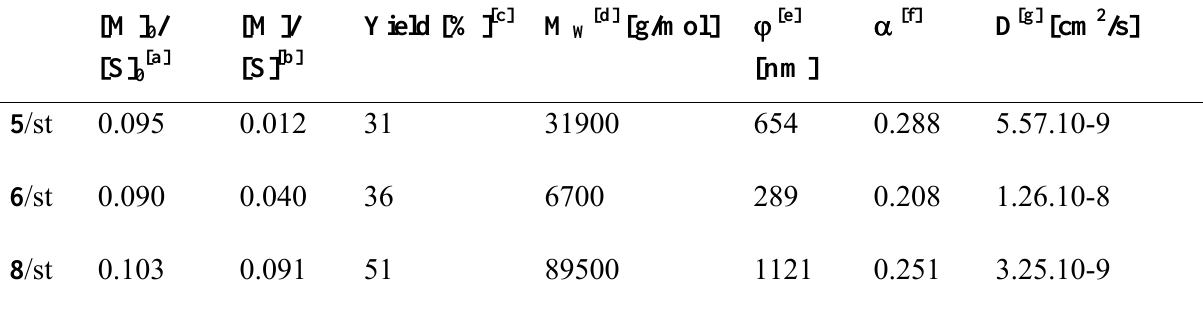
Table 1 . Experimental results for copolymerisation in toluene solutions of 5 , 6 , and 8 with styrene and the radical initiator AIBN, 70 ° C, 48